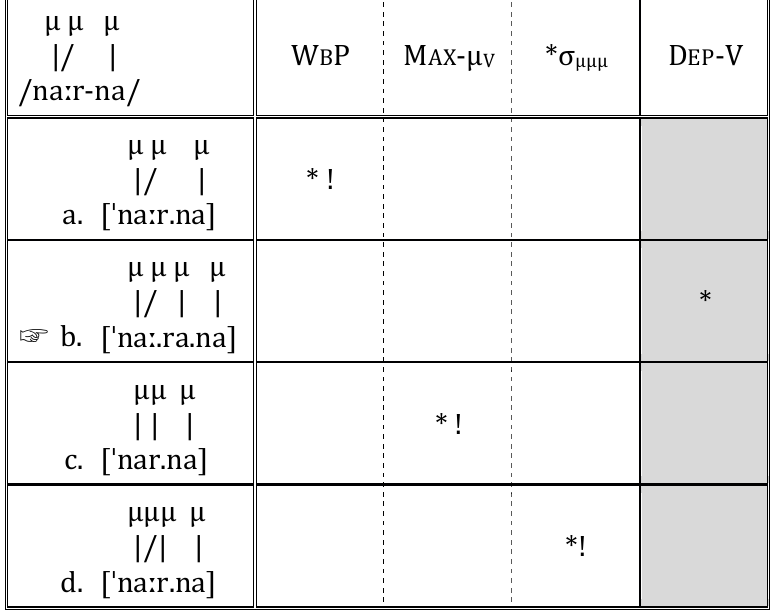
Tableau 1 : A vowel is epenthesized to avoid a violation of W B P and M AX -μ V